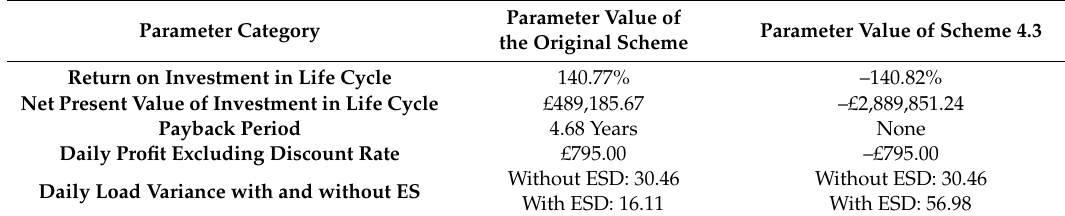
Table 3. Comparison of parameters of Scheme 4.3 with the original